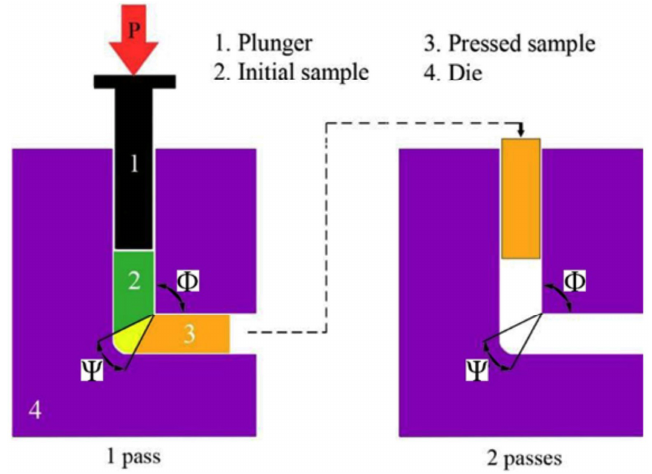
Figure 1. Schematic diagram of the equal channel angular pressing (ECAP) process [53].